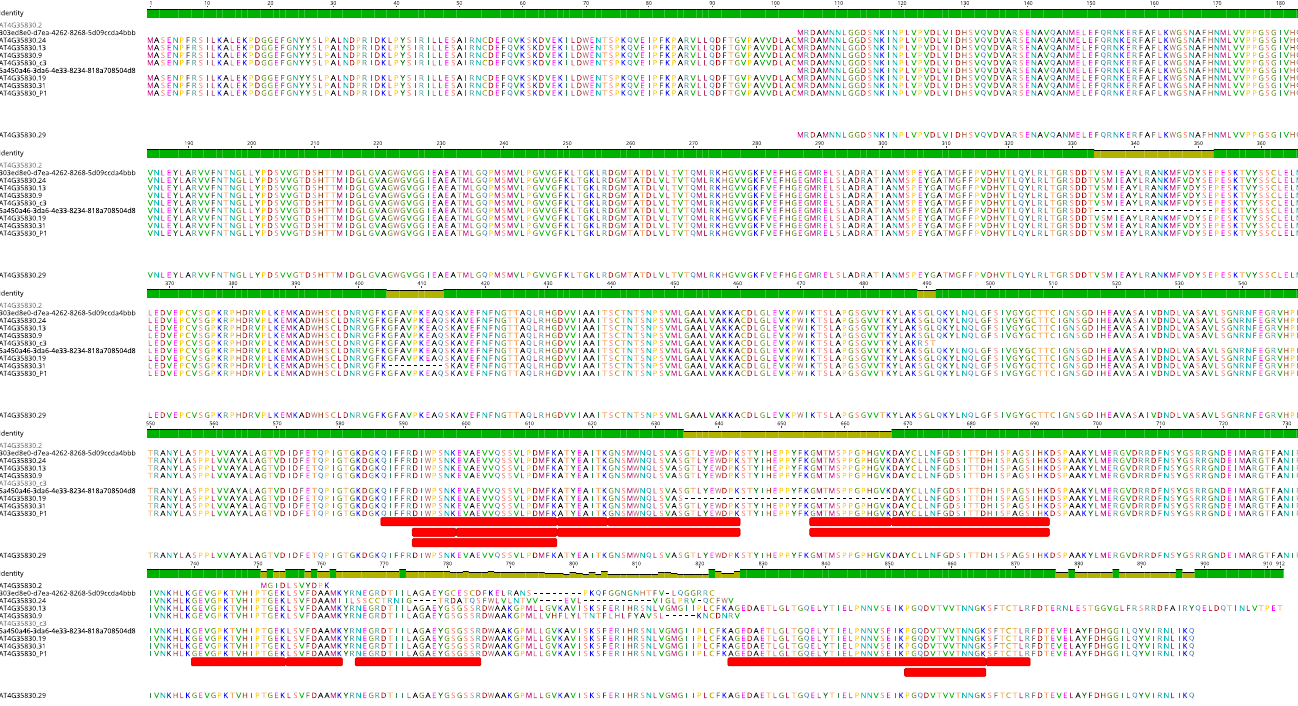
Figure 5. Alignment of the AtRDT2 ACONITASE 1 (ACO1) proteoform AT4G35830_P1 and the ACO1 proteoforms included in AtRTD3_AtONT-DRS containing the peptides assigned as unique peptides to AT4G35830_P1 (red boxes) when performing the protein search using AtRTD2 as the reference protein database. The identity graph displays the degree of identity across all sequences for every position. Green means that the residue at the position is the same across all sequences. Positions with 30% to under 100% identity are represented in